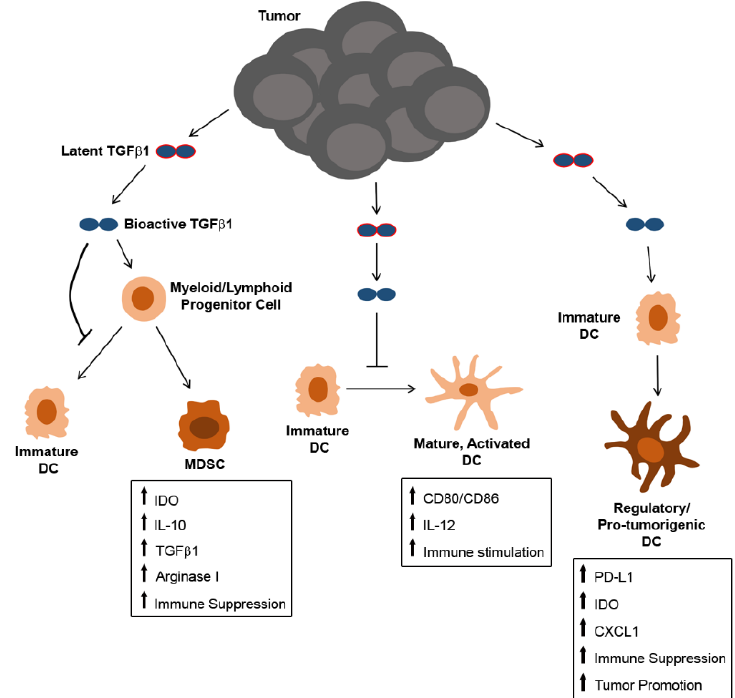
Figure 3. Overview of mechanisms by which tumor-derived TGF β 1 may influence the differentiation and function of DC and their precursors.